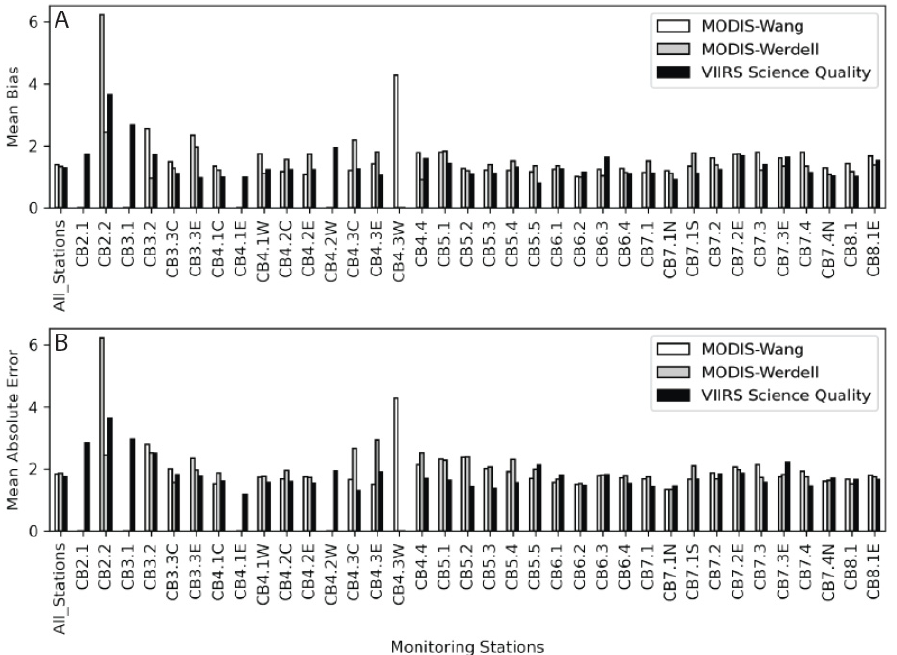
Figure 9. ( A ) Mean bias from the field data and the MODIS-Wang (white), MODIS-Werdell (gray), and VIIRS-SciQual (black) imagery for each station from the CBP. The stations run from left to right and represent a transect from the head of the bay to the mouth of the bay (Figure 1). Values closer to 1 indicate less bias. ( B ) Mean Absolute Error (MAE) is presented in the same fashion as the bias. J. Mar. Sci. Eng. 2022 , 10 , x FOR PEER REVIEW